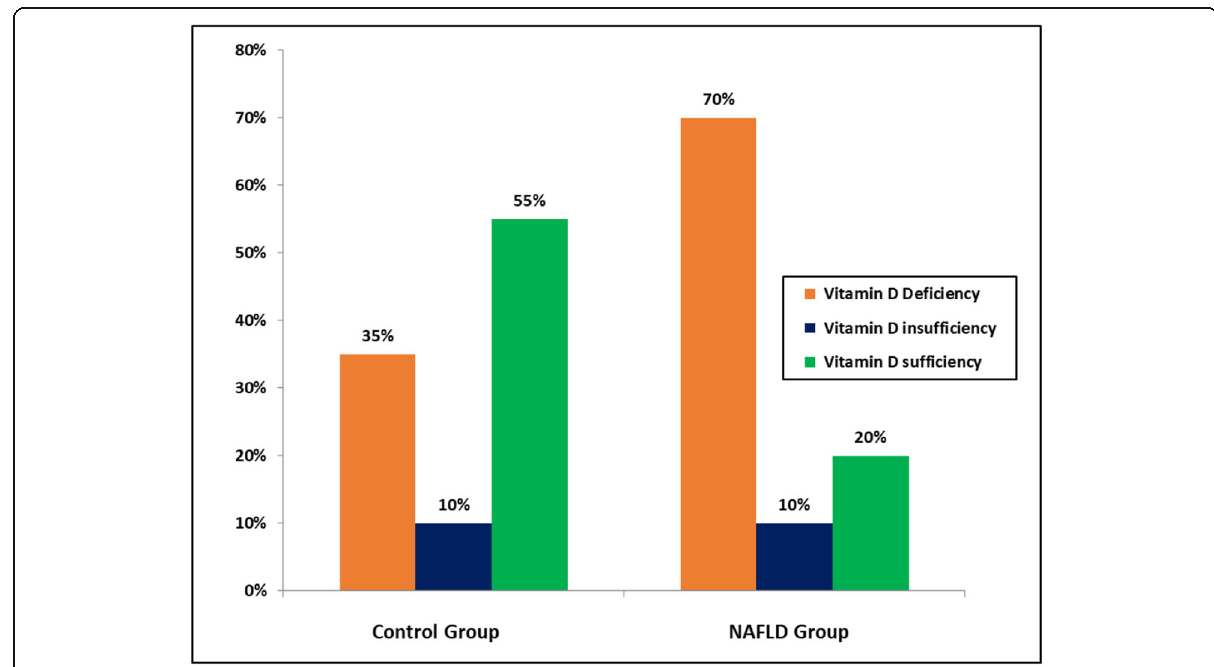
Fig. 1 Comparison of the vitamin D status (serum 25(OH)D) between the study